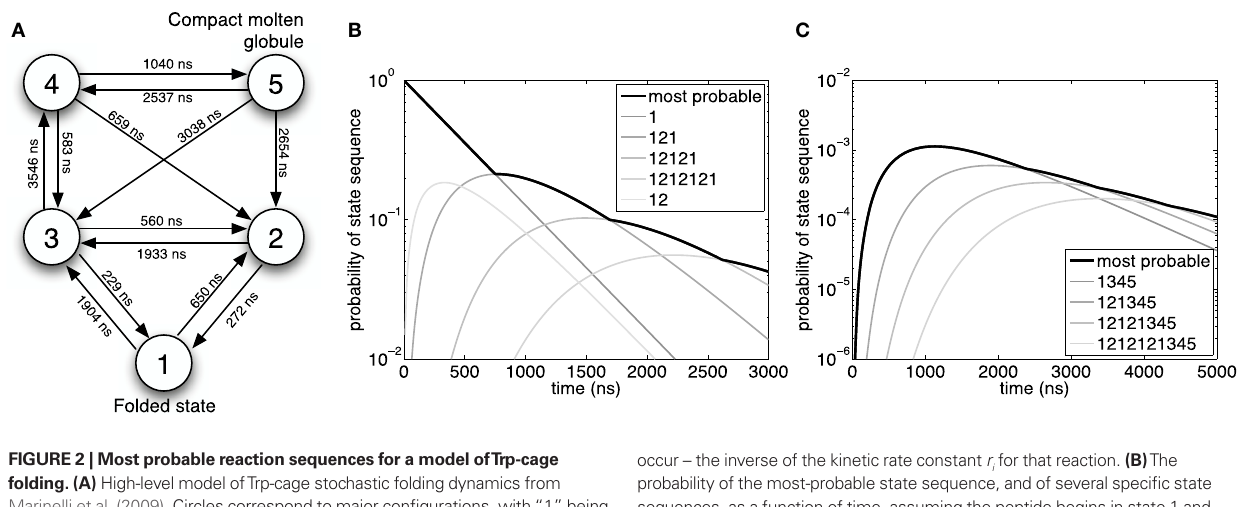
occur – the inverse of the kinetic rate constant r for that reaction. (B) The i probability of the most-probable state sequence, and of several specific state sequences, as a function of time, assuming the peptide begins in state 1 and can end in any state. (C) The probability of the most-probable state sequence, and of several specific state sequences, as a function of time, assuming the peptide begins in state 1 and ends in state